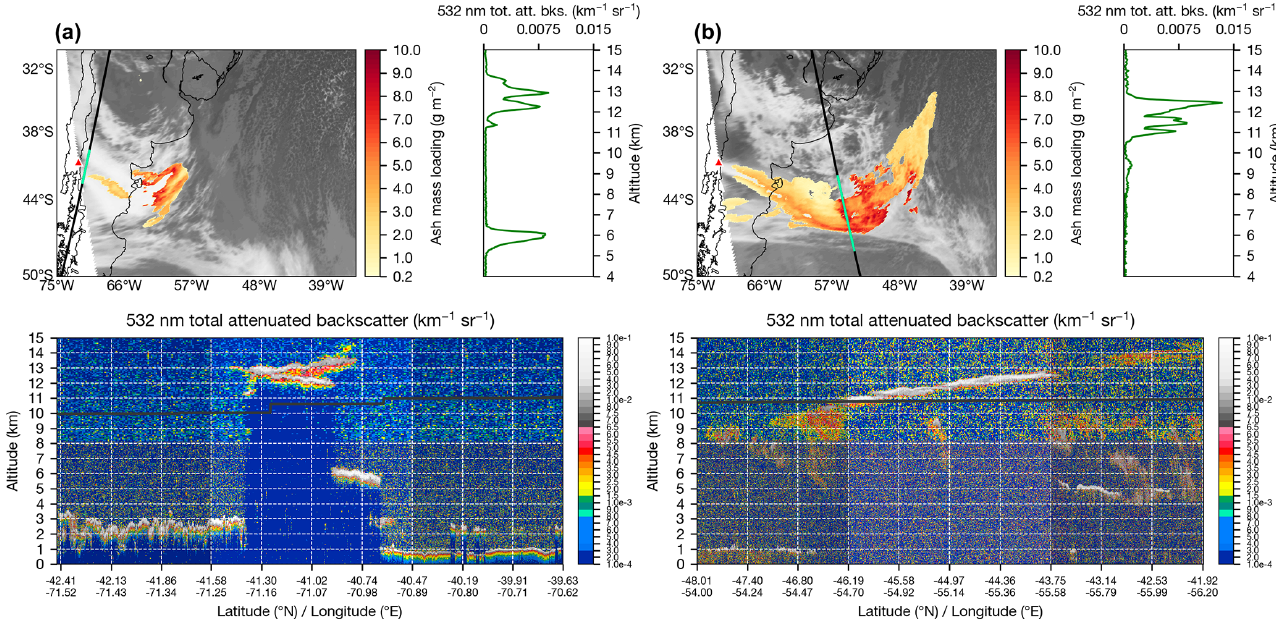
Figure A4. (a) SEVIRI ash mass loadings and CALIOP vertical profile of the Cordón Caulle ash plume on 5 June 2011 at 06:00UTC. Top left panel: mass loading retrievals (yellow–orange–red colour scale) with brightness temperatures plotted underneath (red triangle indicates location of Cordón Caulle). Black line indicates CALIOP track and green highlight indicates full latitude–longitude range displayed in the bottom panel. Top right panel: 532nm total attenuated backscatter profile averaged over the latitude–longitude range highlighted on bottom panel. Bottom panel: 532nm total attenuated backscatter curtain (black line indicates the tropopause). Panel (b) is the same as (a) but for 5 June 2011 at